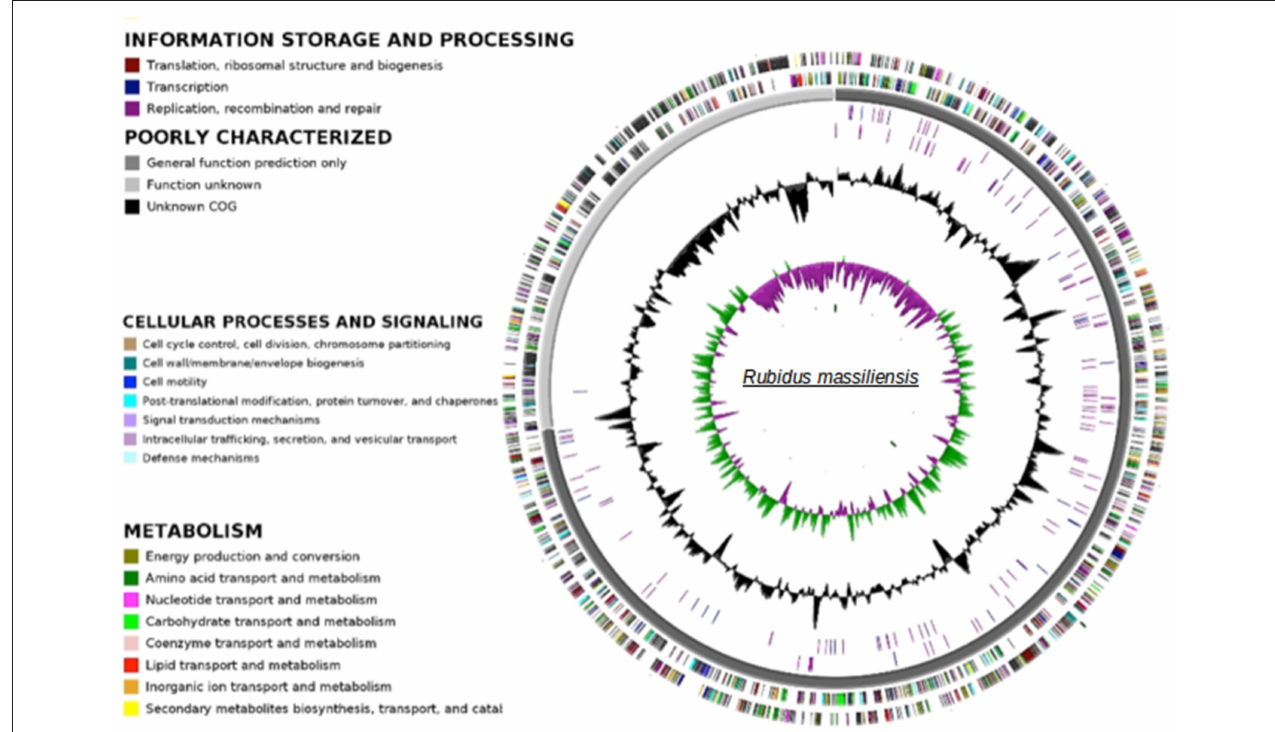
FIGURE 3 | Circular representation of the R. massiliensis chromosome. Circles from the center to the outside: GC skew (green/purple), GC content (black), RNA on forward strand (tRNA in blue, rRNA in purple), RNA on reverse strand (tRNA in blue, rRNA in purple), scaffolds in alternative grays, genes on forward strand colored by COGs categories, genes on reverse strand colored by